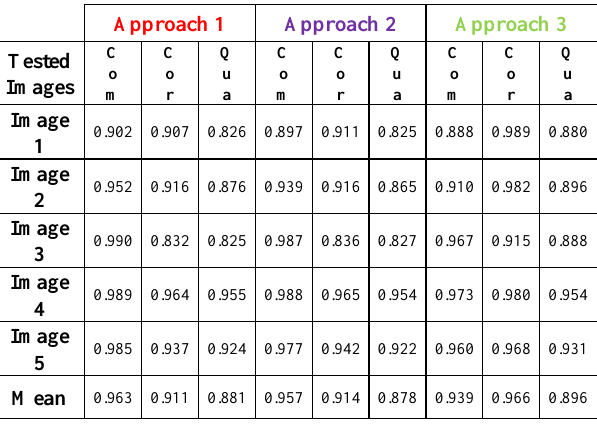
Table 1. Comparison of Completeness (Com), Correctness (Cor) and Quality (Qua) index for the three